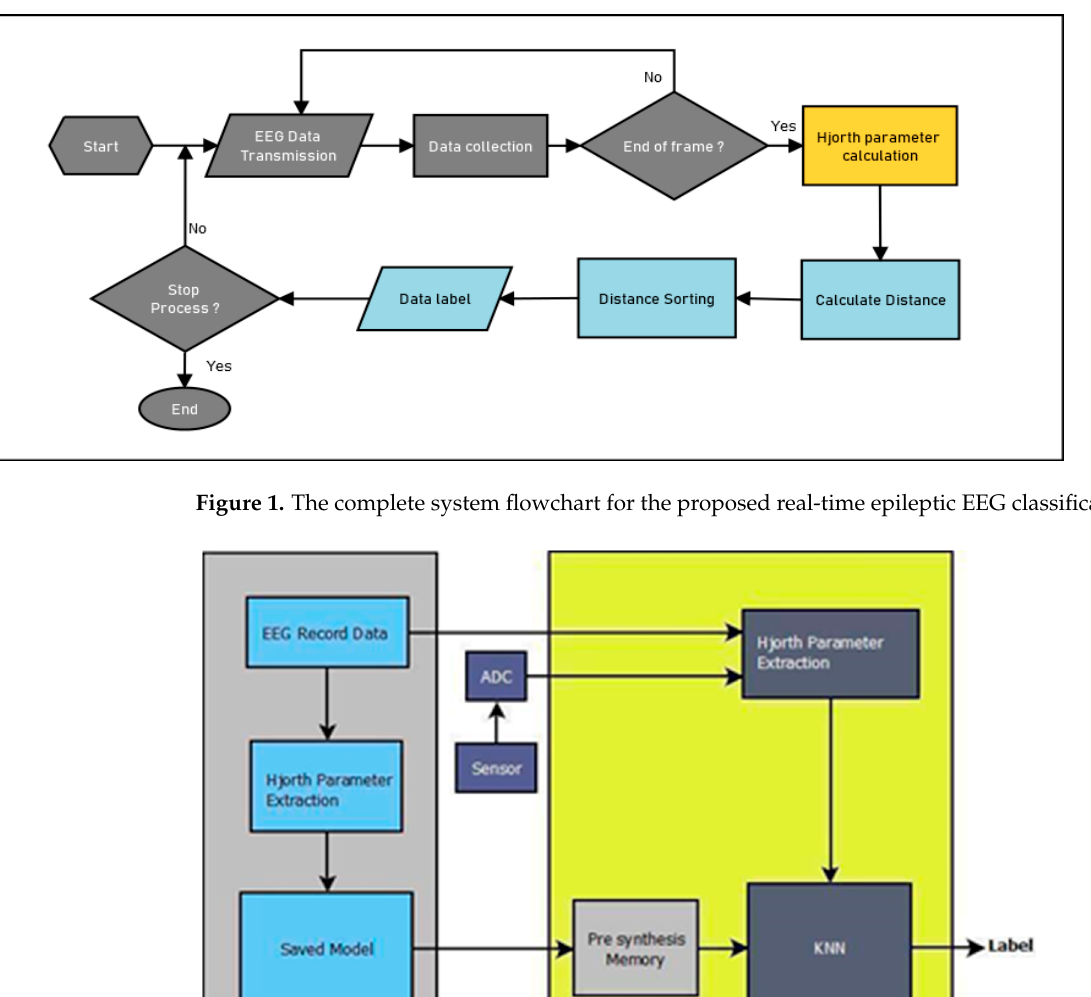
Figure 1 . The complete system flowchart for the proposed real-time epileptic EEG classification .